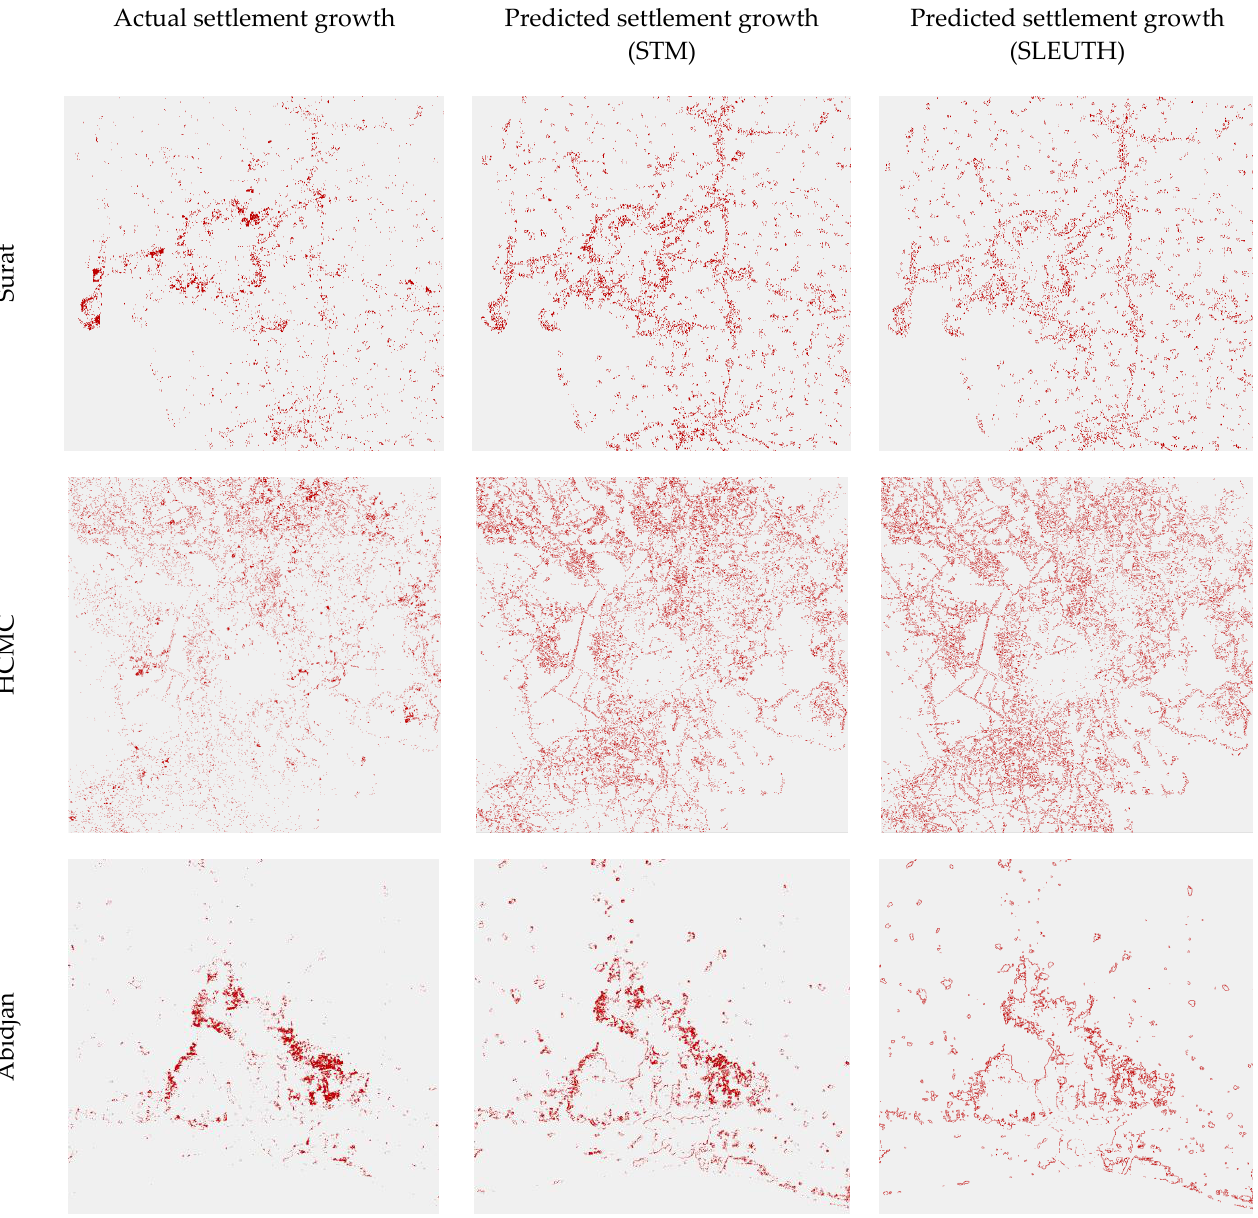
Figure 13. Comparison between the actual settlement growth patterns, the predicted settlement growth patterns from the STM-based model, and the predicted growth patterns from the SLEUTH model. Results are illustrated in binary images, with dark red pixels representing urbanized cells from 2006 to 2015.